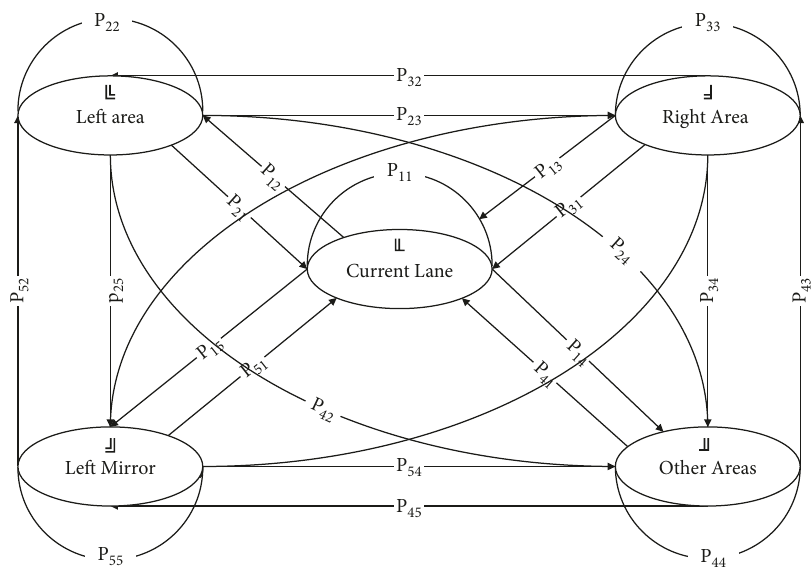
Figure 5: A depiction of eye glance pattern with proportions. Table 3: Proportions of gaze transition for the five